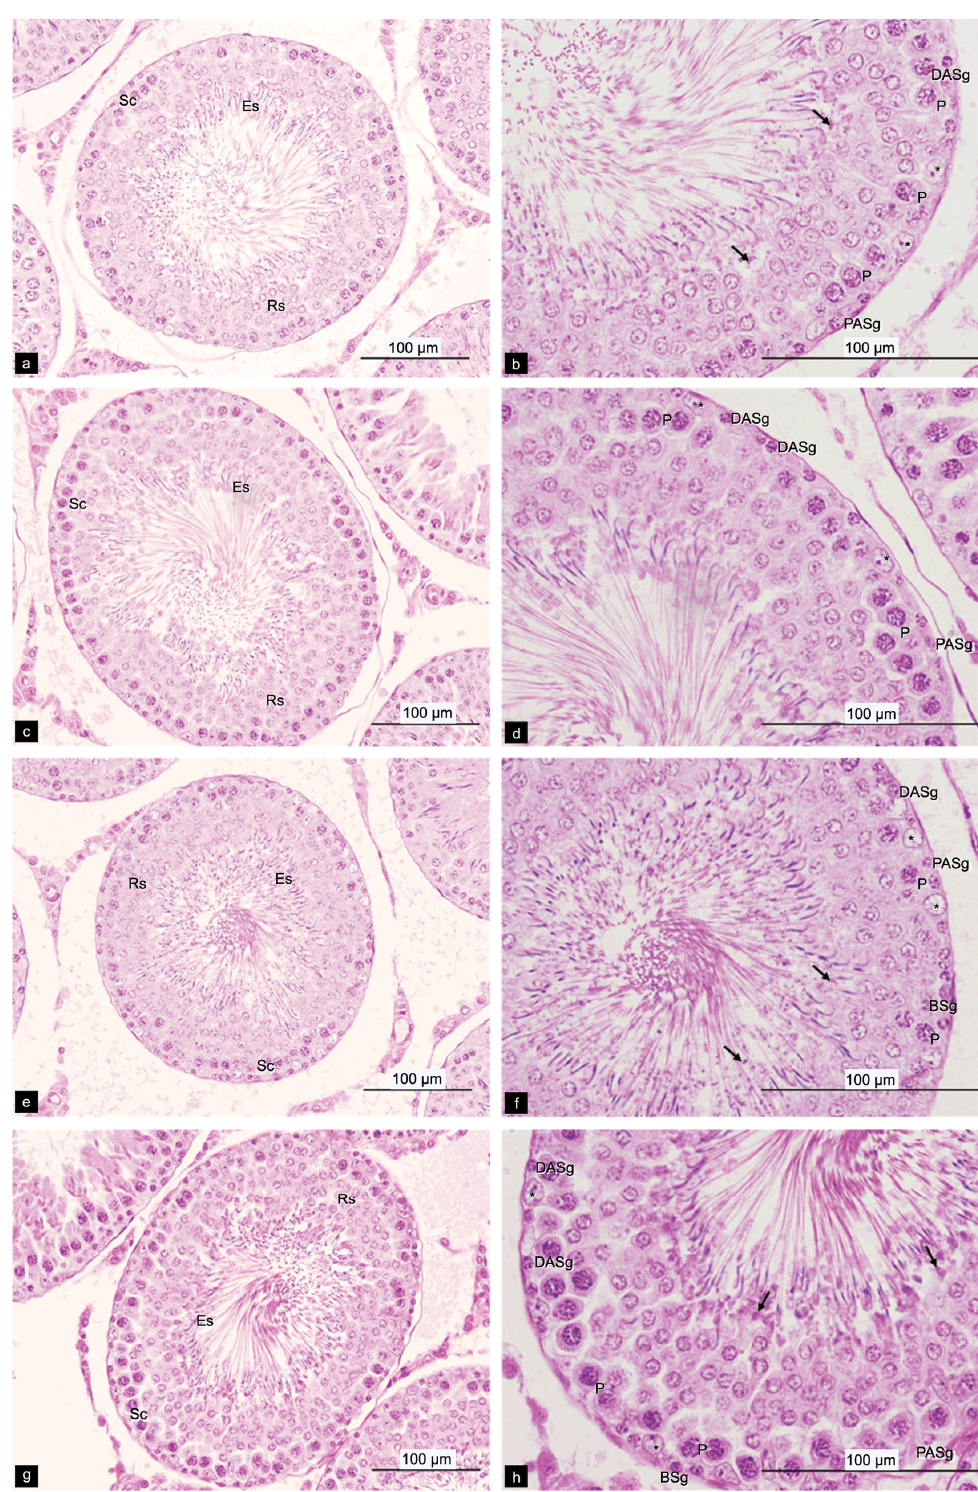
Figure 5. Photomicrographs of rat testis sections stained with H&E, showing the stages VII or VIII of the seminiferous epitheliums. ( a , b ) Control group; ( c , d ) Rats received M. Oleifera leaf tea 0.55 mg/kg; ( e , f ) Rats received M. Oleifera leaf tea 1.10 mg/kg; ( g , h) Rats received M. Oleifera leaf tea 2.20 mg/kg. The black arrow ( → ): Residual bodies; DASg: Dark type A spermatogonia; PASg: Pale type A spermatogonia; BSg: Type B spermatogonia; Sc: Spermatocytes; P: Pachytene primary spermatocytes; Rs: Round spermatids; Es: Elongate spermatids; *: Sertoli cells.